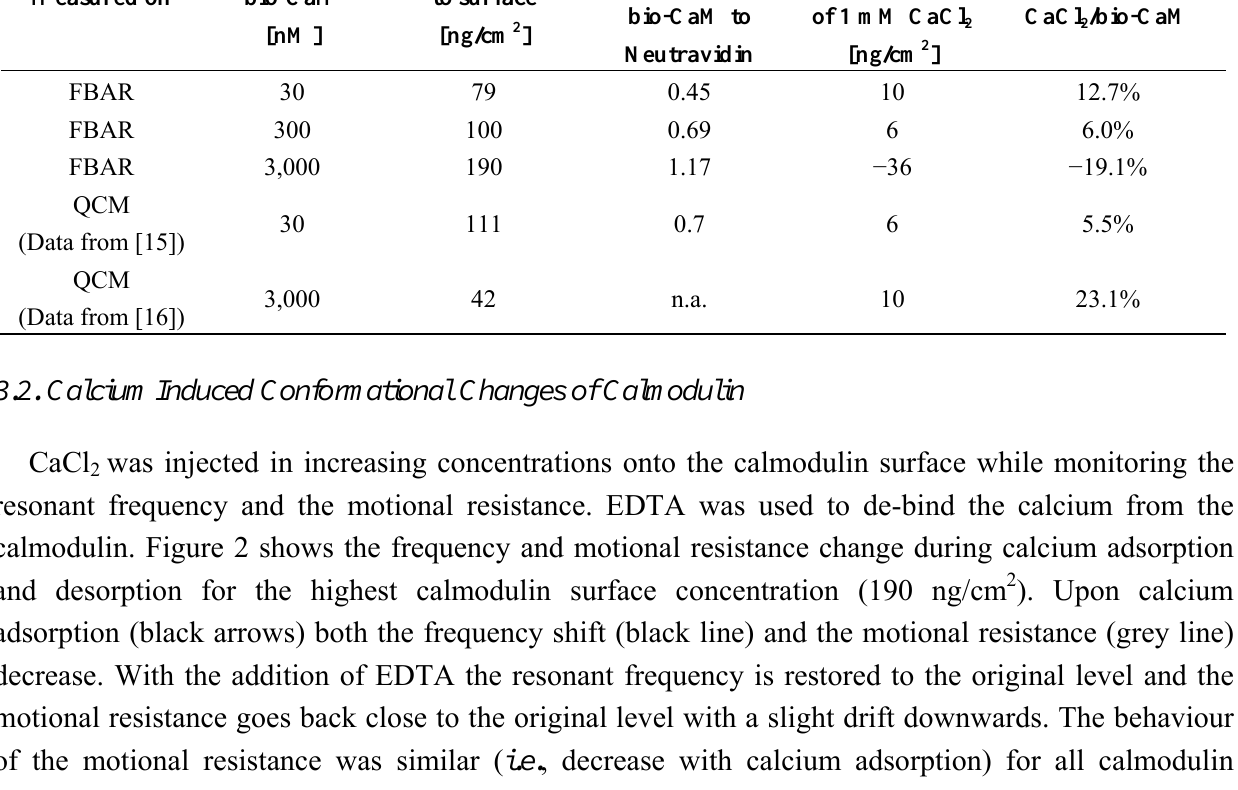
adsorption of the FBAR 2